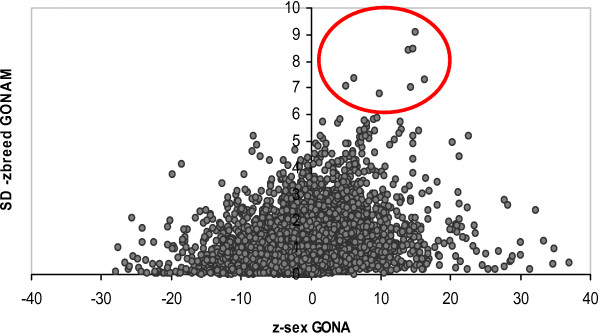
Sex bias vs. variability of breed z-scores in male gonads. In abscissas, the sex z-score in gonads; in ordinates, the standard deviation of breed z-scores in the male gonads, i.e., a probeset with a high ordinate value is a probeset whose expression level in testicles varied largely between breeds. Each dot corresponds to a different probeset. The probesets encircled are those with largest variability across breeds which, as can be seen, are male biased but are not the most sex biased.